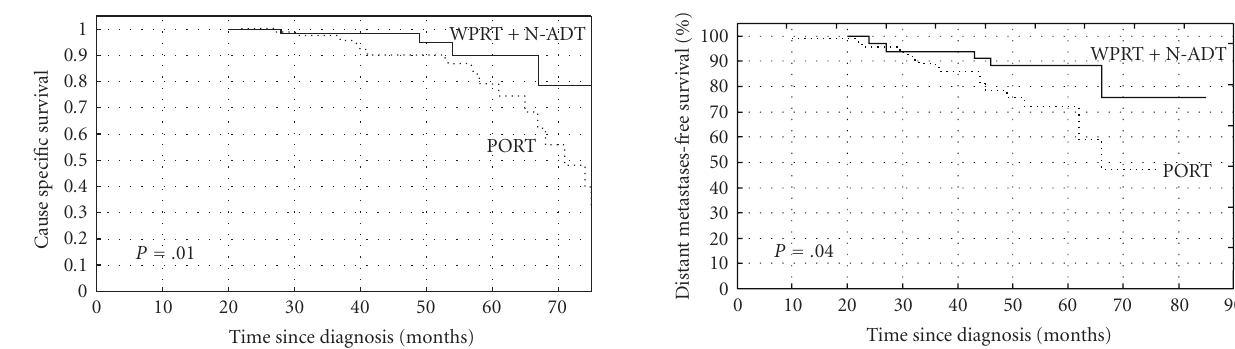
On multivariate analysis combined treatment (WPRT + N-ADT) ( P = . 01), lower PSA level ( P = . 01) and lower risk of lymph nodes involvement ( P = . 01) were statistically significantly associated with longer CSS (Table 3).